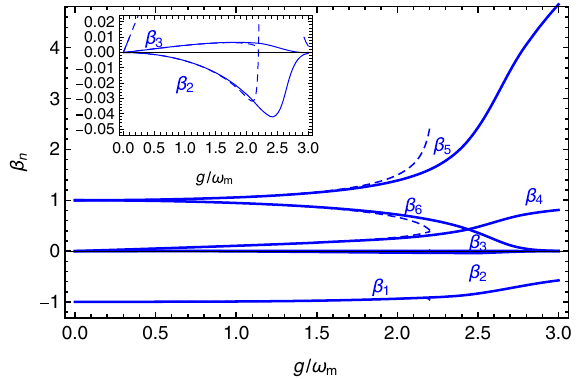
FIG. 6. Comparison between numerical (solid line) and ana- lytical (dashed line) dependence of the anharmonicity parameter a for three values of the coupling g= ω